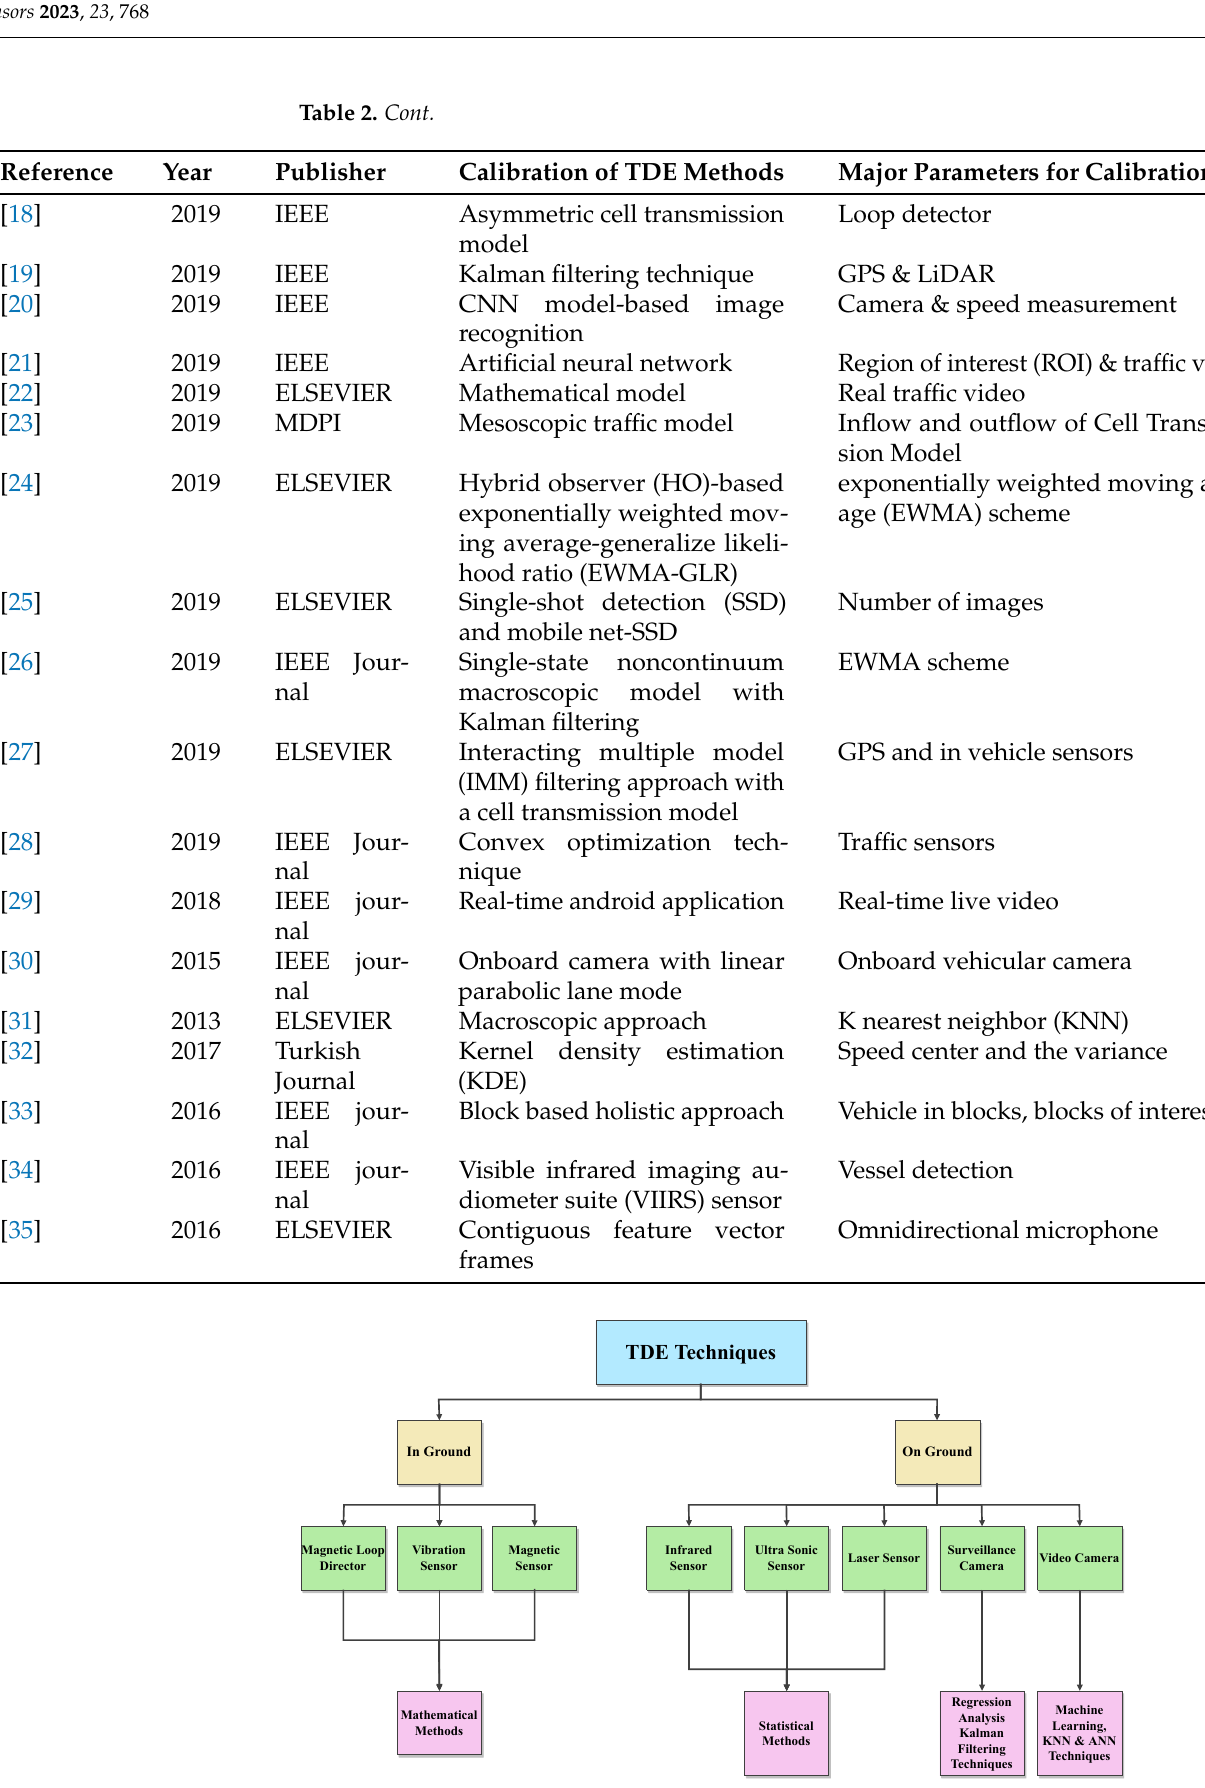
Figure 2. Taxonomy of Traffic density estimation